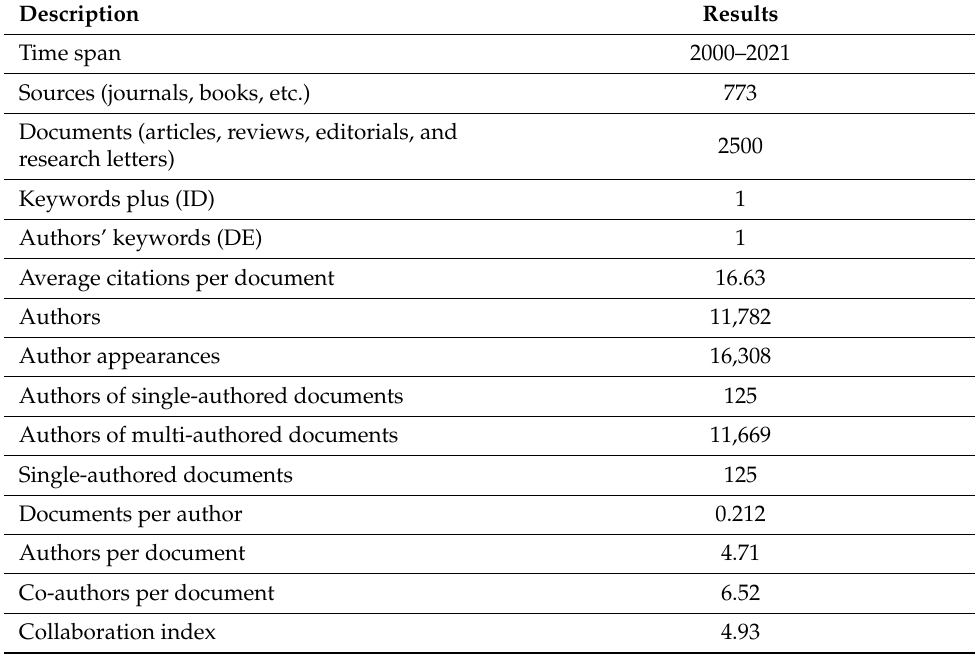
Table 1. Information about studies on RuV on Dimensions from 2000 to